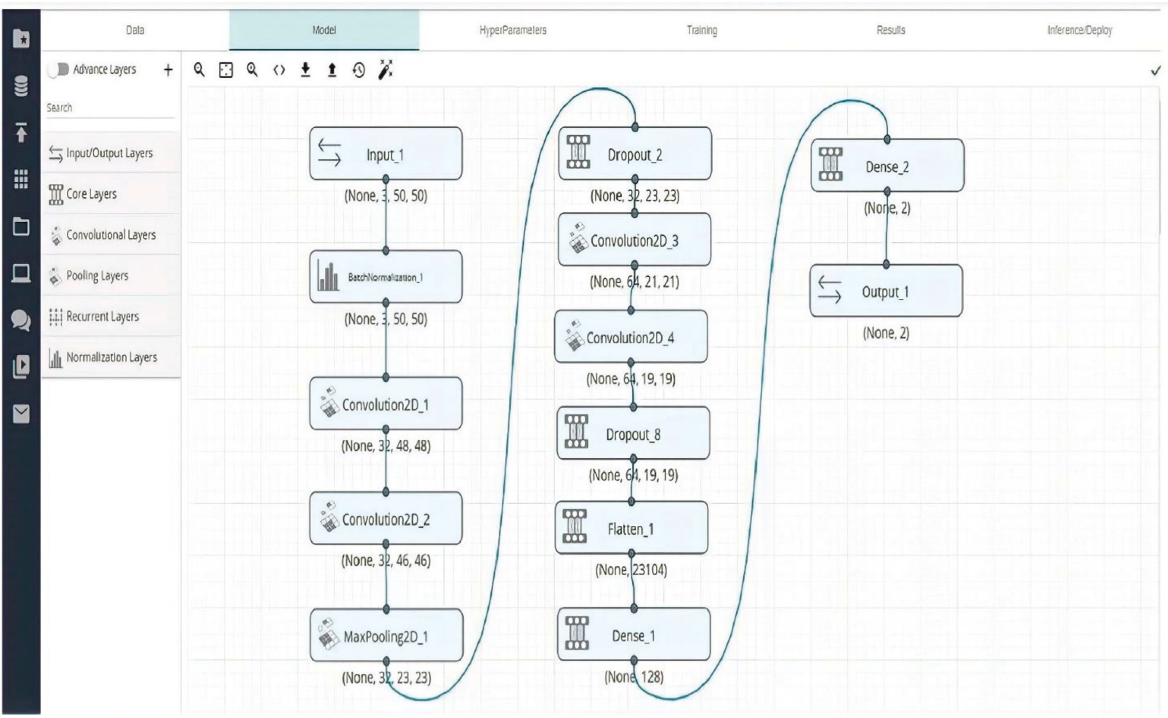
Figure 2: DLS model-driven architecture